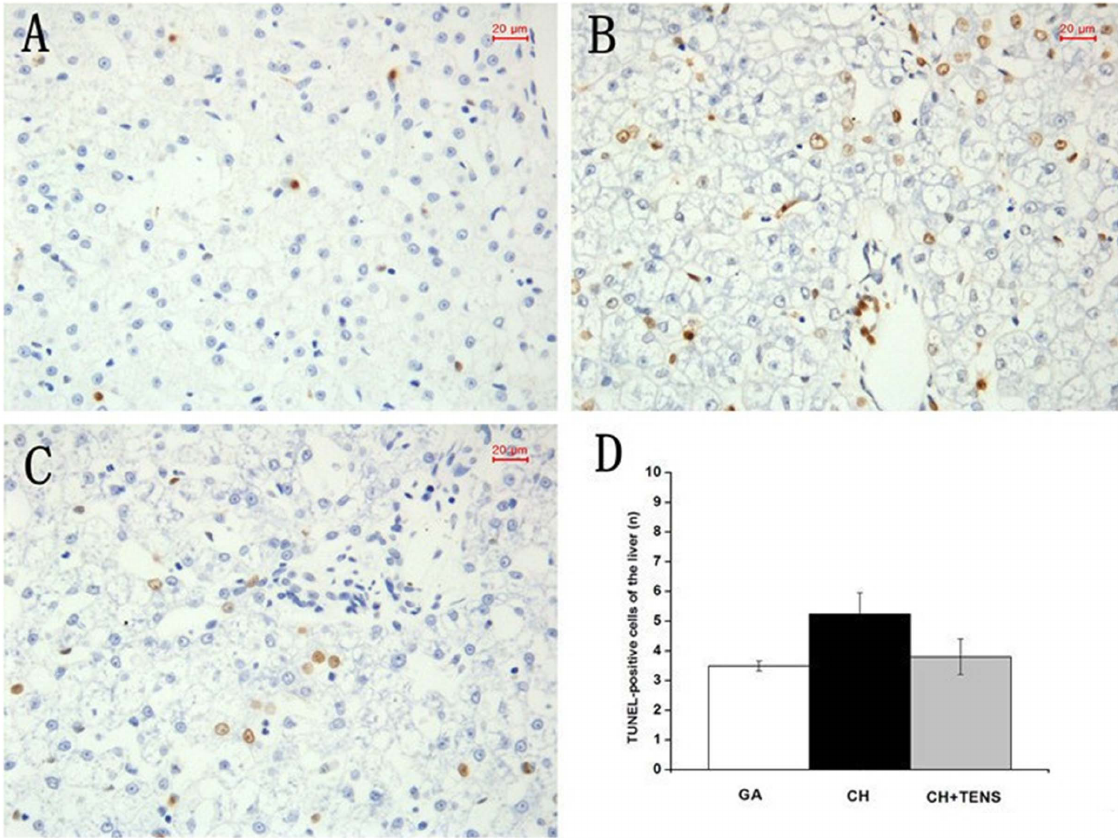
Figure 7. Terminal deoxynucleotidyl transferase-mediated dUTP-biotin nick end labeling (TUNEL) staining of canine hepatic tissue after controlled hypotension (CH). The number of TUNEL-positive cells was quantified at a high magnification ( 6 400). Relatively more TUNEL- positive cells were found in the CH group when compared with the GA group, but this trend was not significant. The number of TUNEL-positive cells is presented as mean 6 standard error of the mean. n=6 per group. Scale bar =20 m